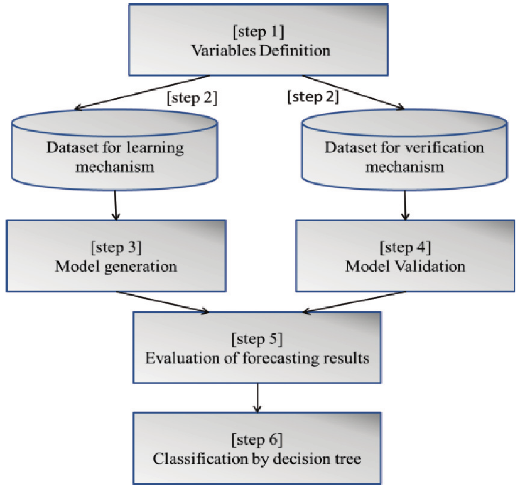
Fig. 3. Procedure of demand